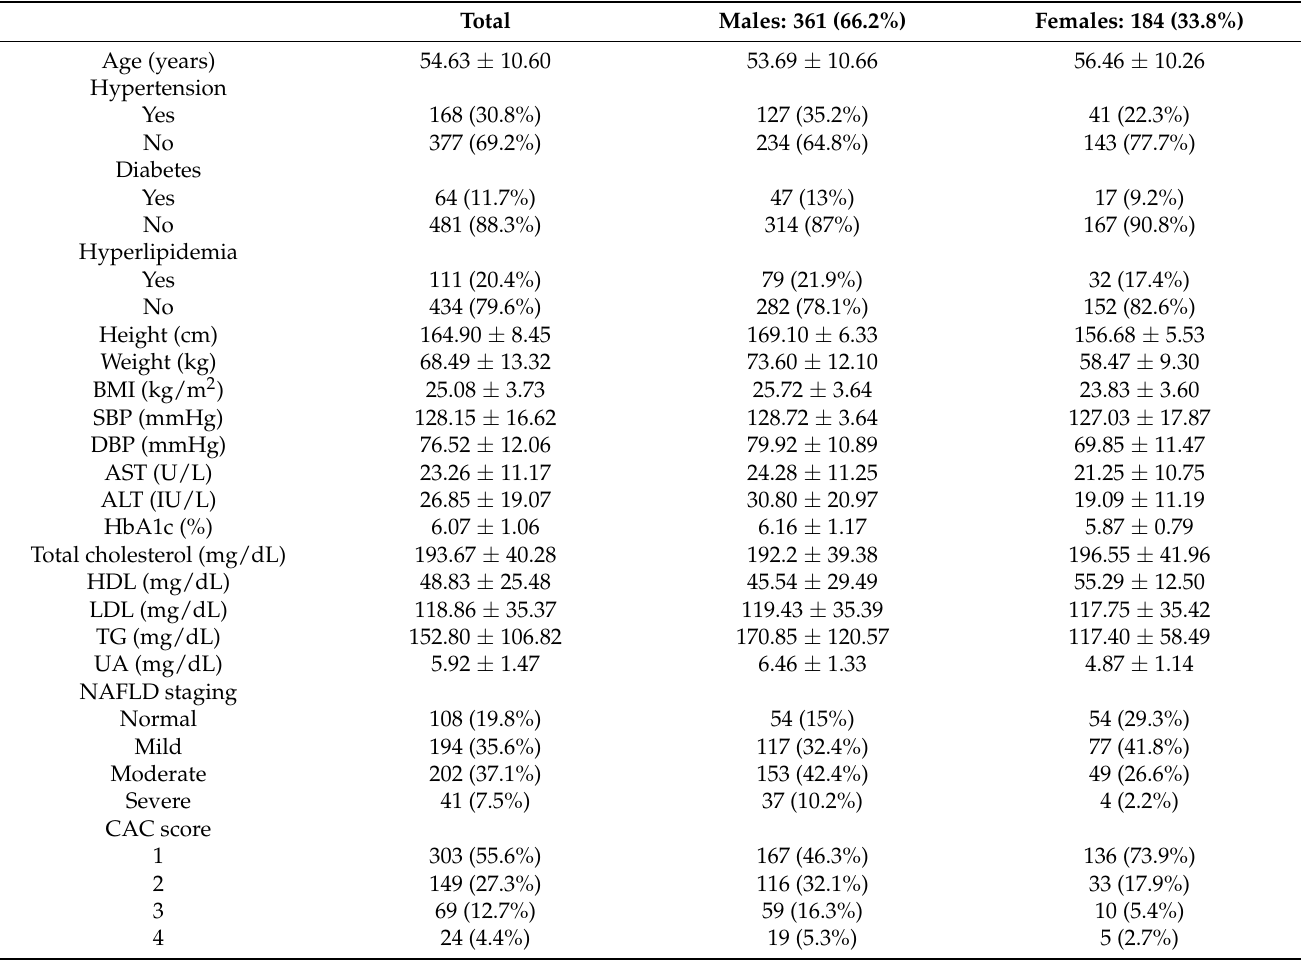
Table 1. Basic characteristic of the enrolled